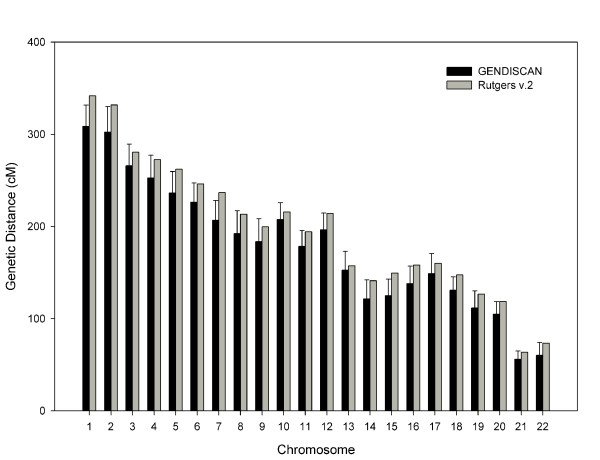
Comparison of female genetic lengths of the chromosomes between the GENDISCAN map and Rutgers Map v.2. Error bars represents the 95% confidence intervals from the paired t-tests.